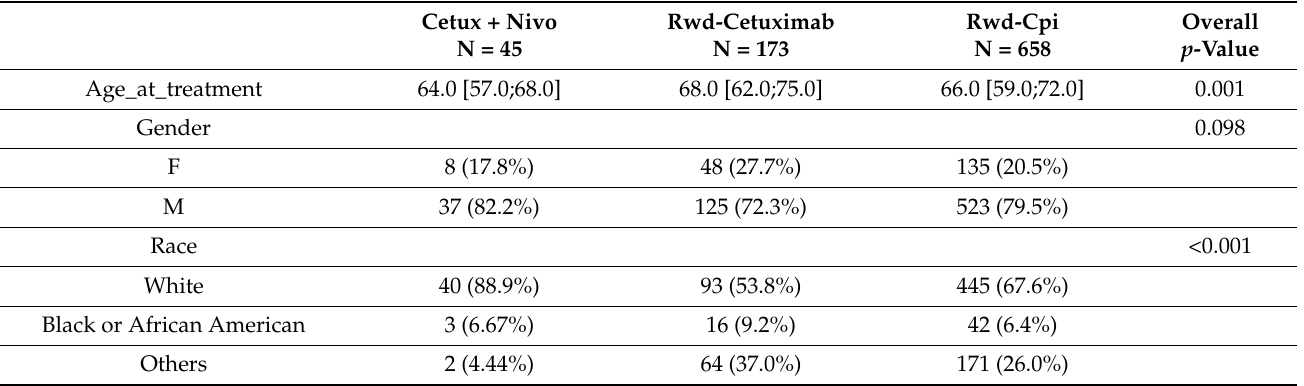
Table 1. Patient